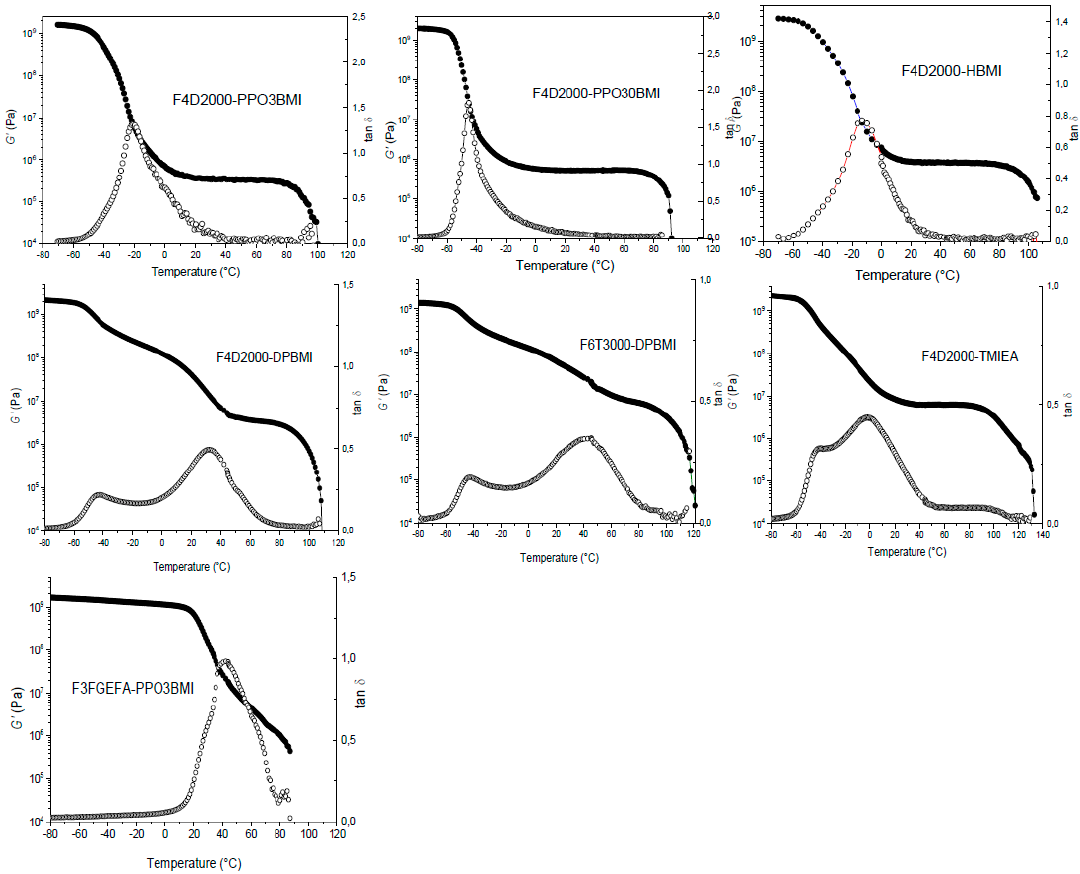
Figure 12. Storage modulus G’ ( ● ) and loss factor tan δ ( ○ ) of the thermoreversible networks as of functions of temperature.